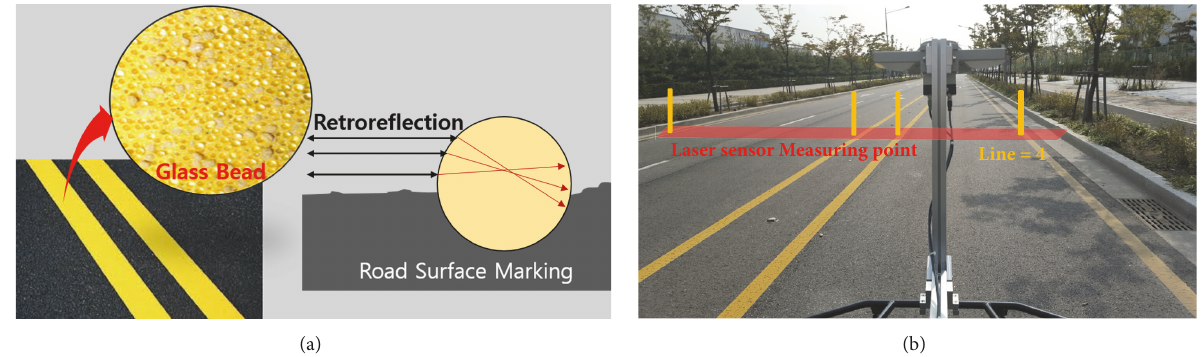
Figure 2: Glass bead in the lane marking and the experimental site used for road feature extraction: (a) the retroreflection phenomenon of the lane marking and (b) a section of the experimental site.